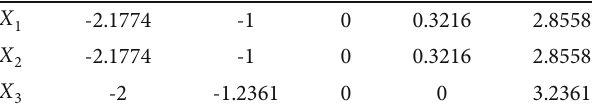
Table 3: The eigenvalues of graphs X X